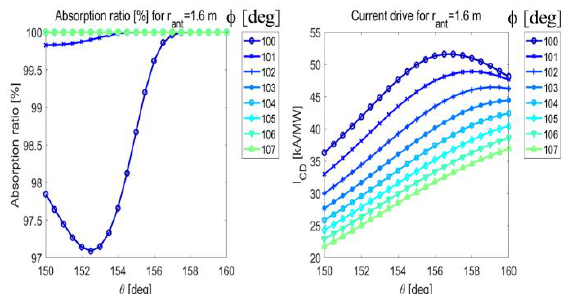
Fig. 4. The power absorption and current drive for injection angles.